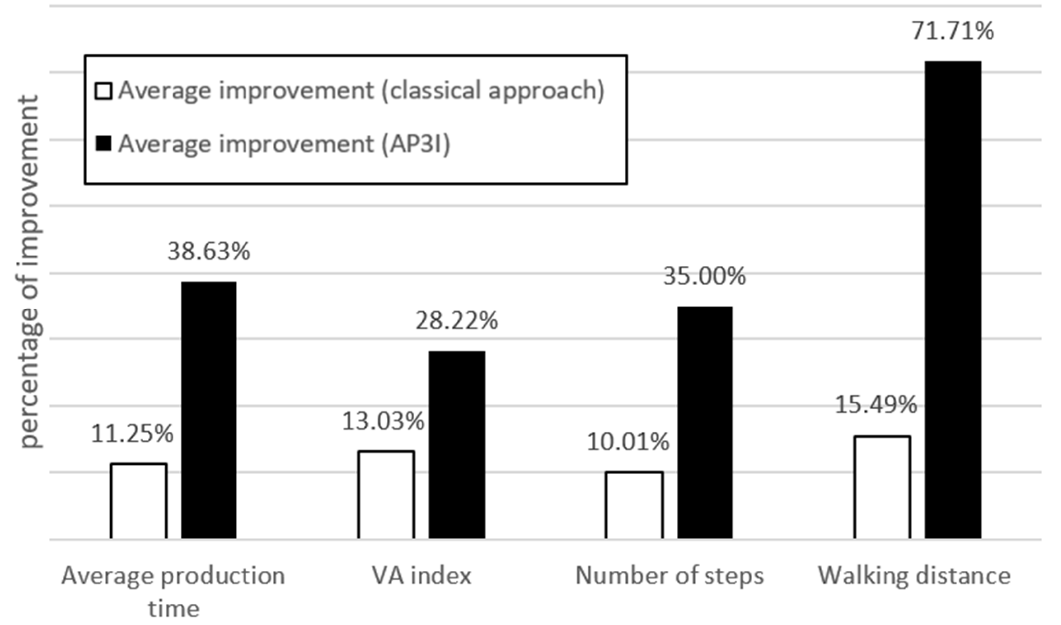
Figure 13. Overall relative improvement rates of process indicators.